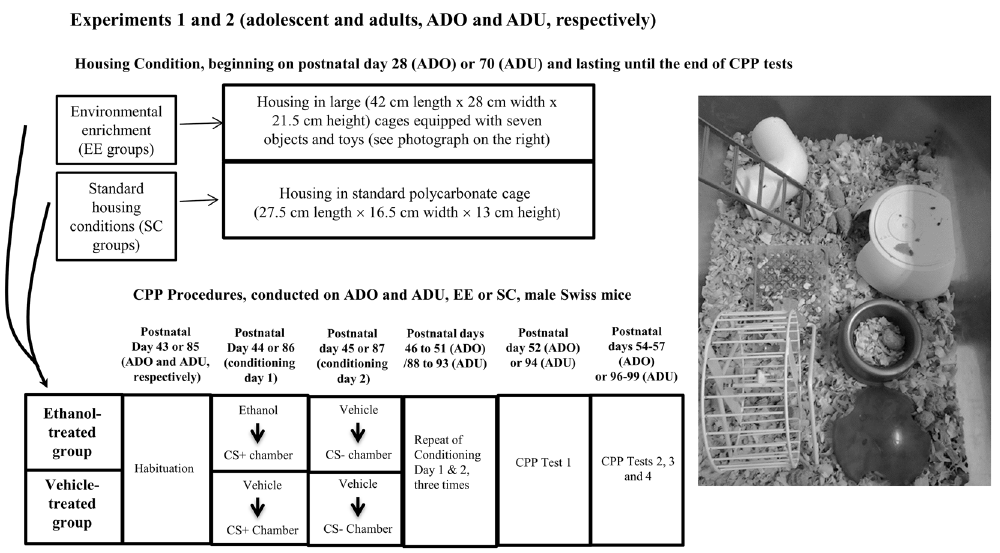
Figure 1. Adolescent and adult mice under environmental enrichment conditions were housed in large transparent polycarbonate cages (42 cm length × 28 cm width × 21.5 cm height) equipped with seven objects and toys, including a running wheel, ladders, pipes and house-like objects. One of the objects was a round container that contained food. The placement and composition of these non-chewable plastic objects were changed every week to prevent habituation. The photograph illustrates one of these